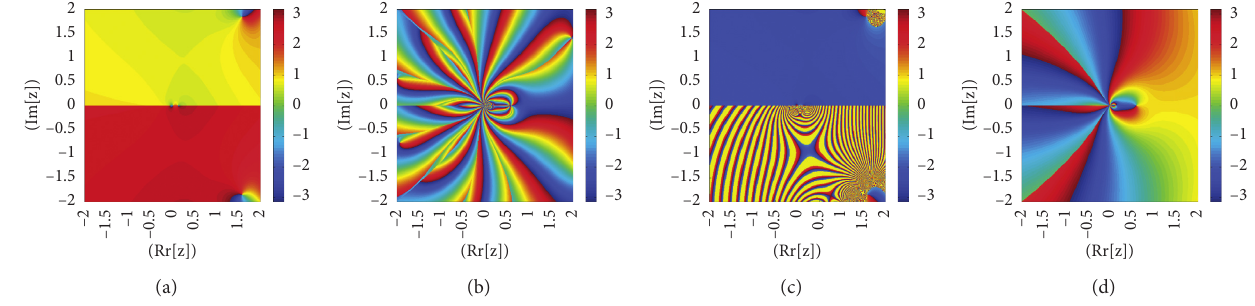
( r ) � r 3 + r − 40 of the iterative methods WDK, IWDK, 1